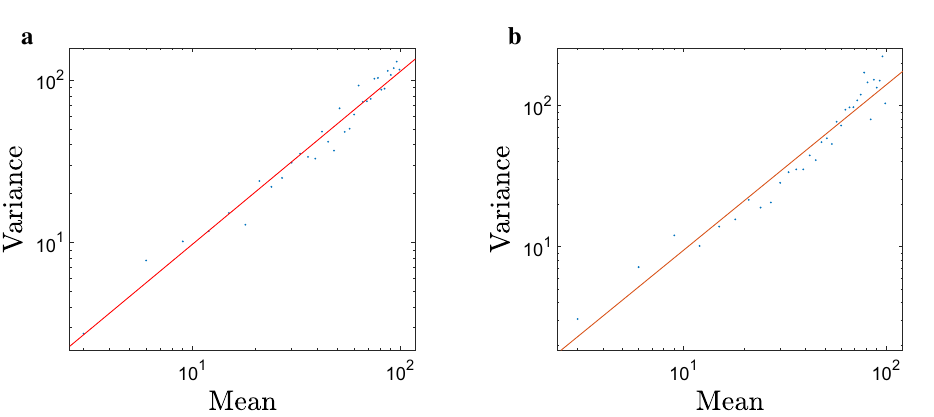
Figure 6. The mean Morisita Index from 10 simulation runs for different number of slugs: ( a ) N 5 10 3 and ( c ) N 10 4 . Here R 200 and d 10 , other parameters are as in Fig. 2. The red curves ( b ) N = · = = = show the Morisita index obtained in the corresponding cases of a purely random individual movement, i.e., without any density dependence.